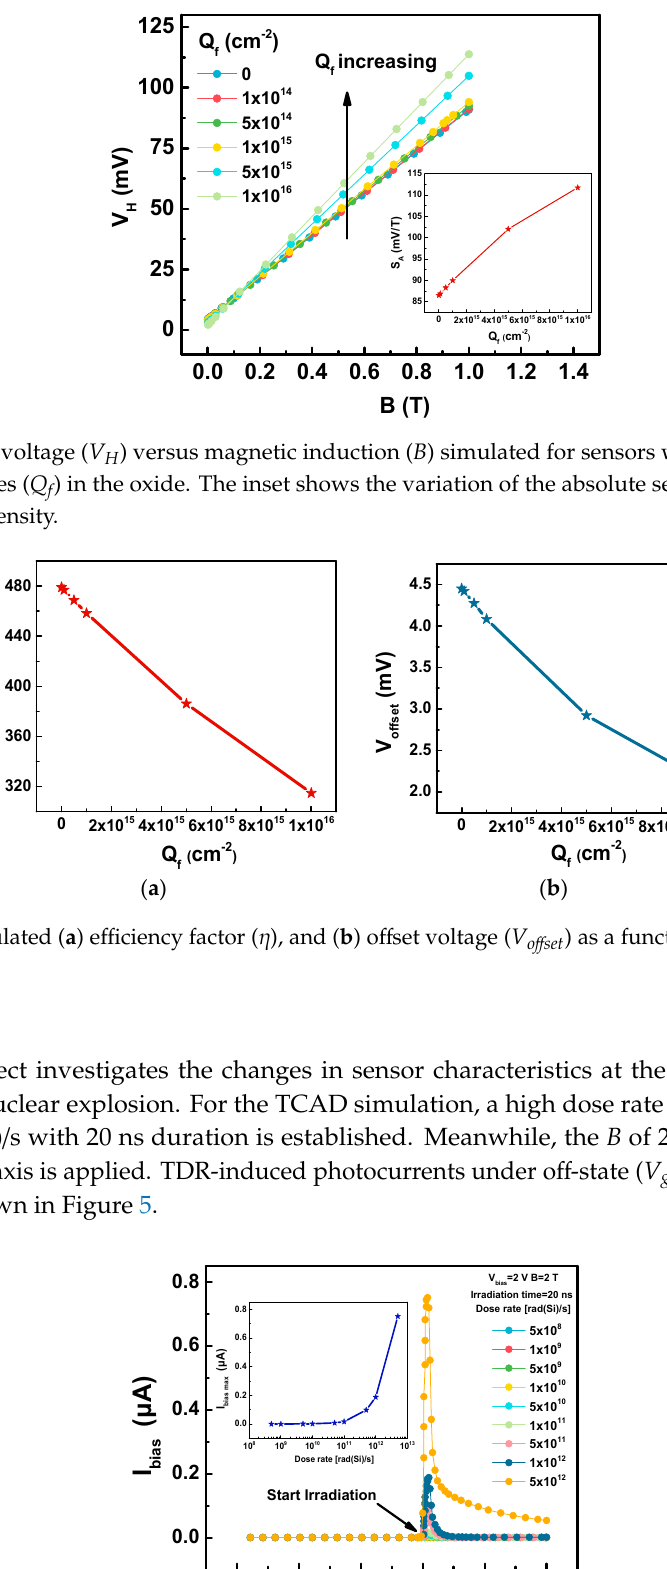
Figure 3. Hall voltage ( V H ) versus magnetic induction ( B ) simulated for sensors with different fixed charge densities ( Q f ) in the oxide. The inset shows the variation of the absolute sensitivity ( S A ) with fixed charge density.